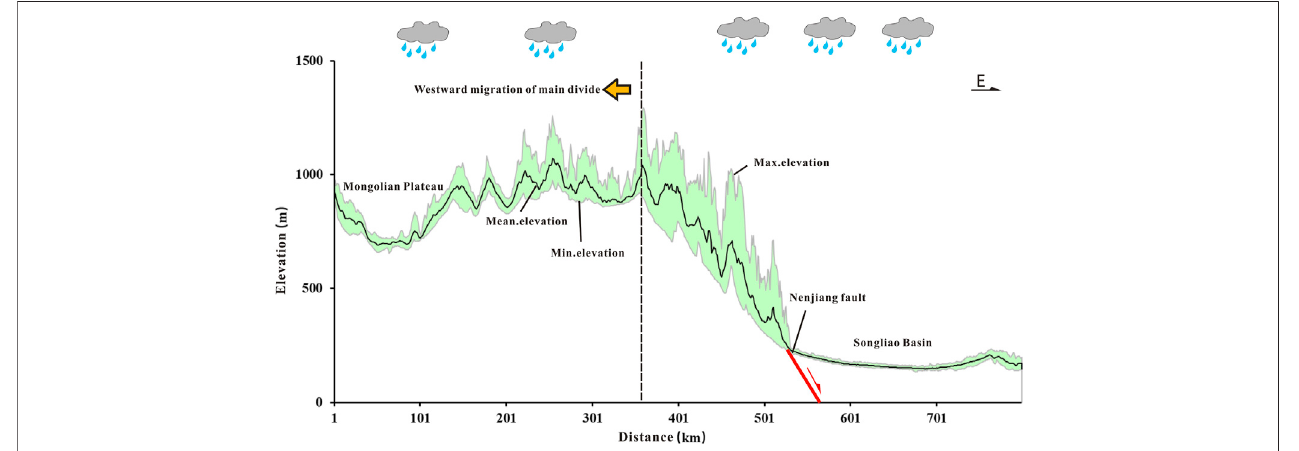
FIGURE 13 | The swath pro fi le across the southern sections of the Greater Khingan Mountains demonstrate that the main divide migrated westward.